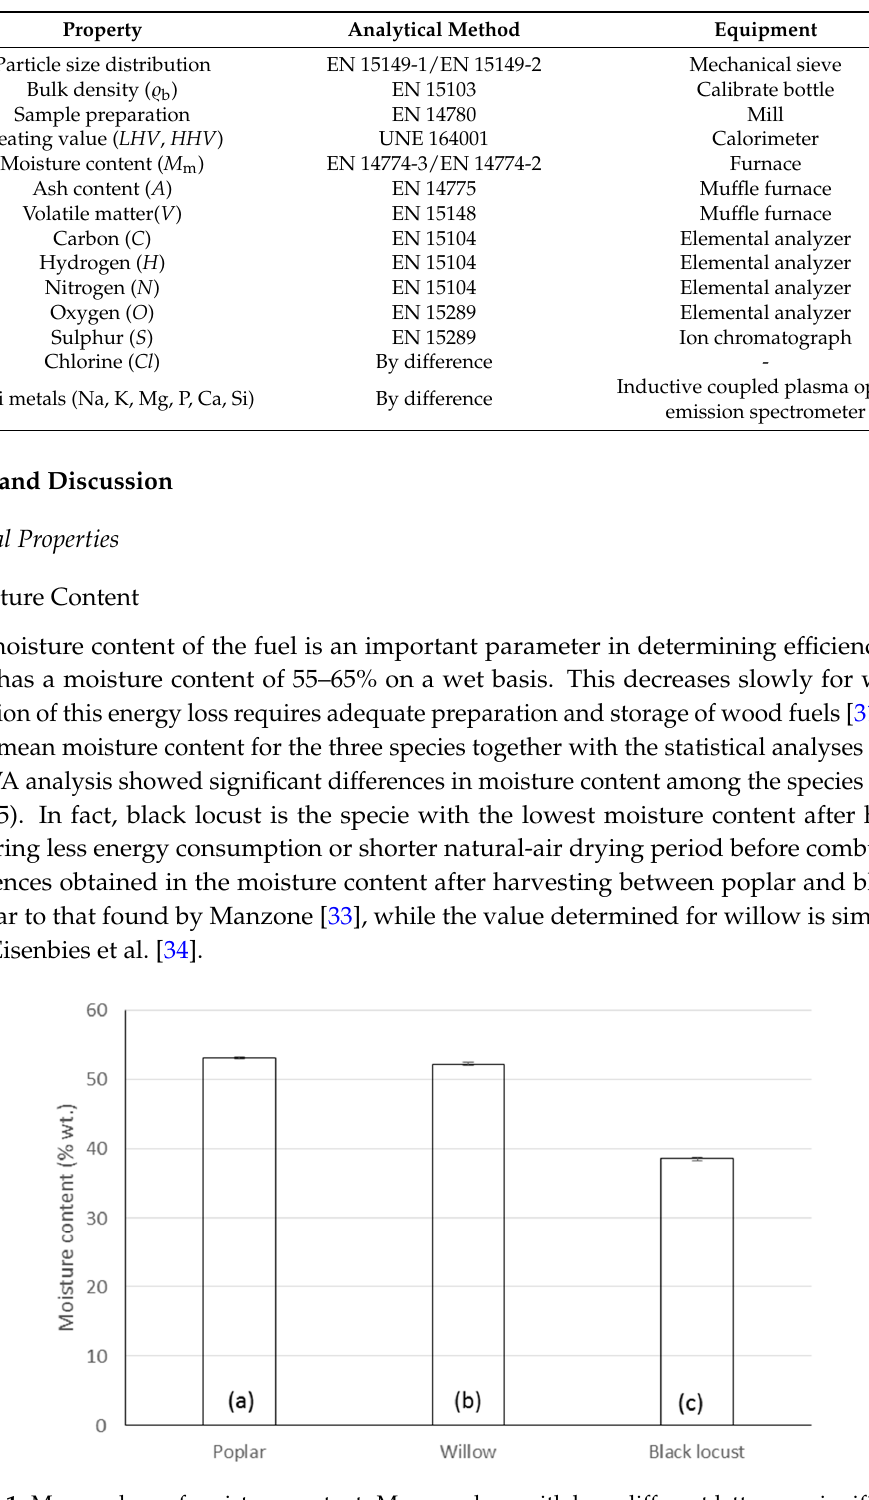
Table 3. Summary of methods and equipment for the characterization.